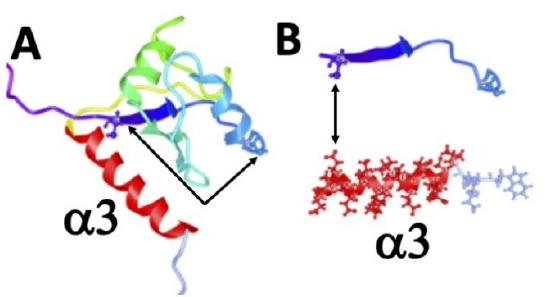
Figure 8. The α 3-helix and the cysteine residues in the RRM2 domain . ( A ) The anti-La mAb 7B6 is directed to the α 3-helix of the RRM2 domain. The accessibility of the epitope is sensitive to oxidation. The RRM2 contains two cysteine residues Cys232 and Cys245 (see arrows). ( B ) The cysteine residue Cys232 locates upstream of the ß-sheet1, while the cysteine residue Cys245 locates downstream of the ß-sheet in an unstructured region. In the RRM2 domain, the two cysteine residues are located at opposite sites (see arrows in ( A , B )). In order to form a disulfide bridge, both cysteine residues must be positioned in close vicinity, which would require a refolding of the RRM2 domain.